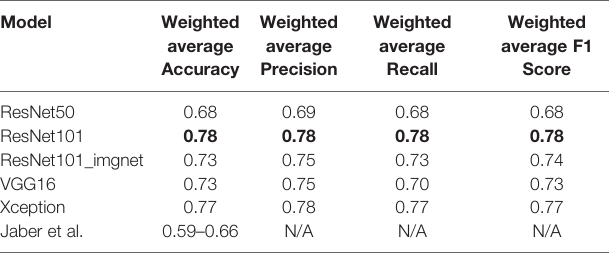
Bold font denote the best model. N/A: no information